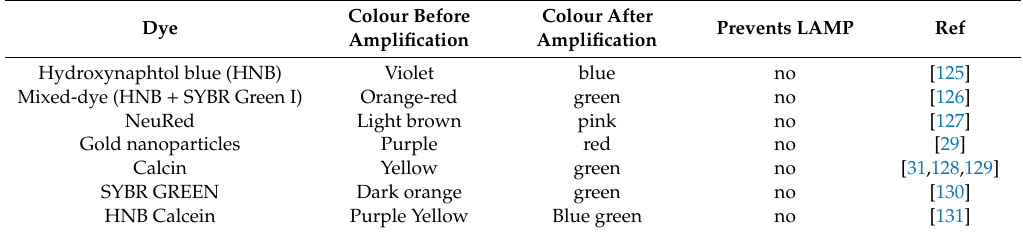
Table 3. Di ff erent dyes employed for bacterial Loop-mediated isothermal amplification (LAMP) identification. Colour Before Colour After Dye Prevents LAMP Ref Amplification Amplification Hydroxynaphtol blue